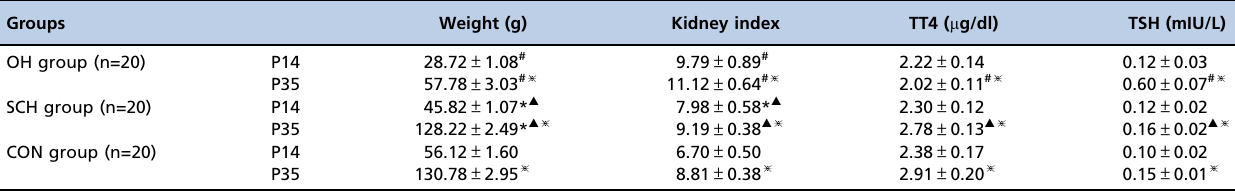
Table 1 - Baseline clinical and laboratory characteristics of the study population ( (cid:1) x ± s).